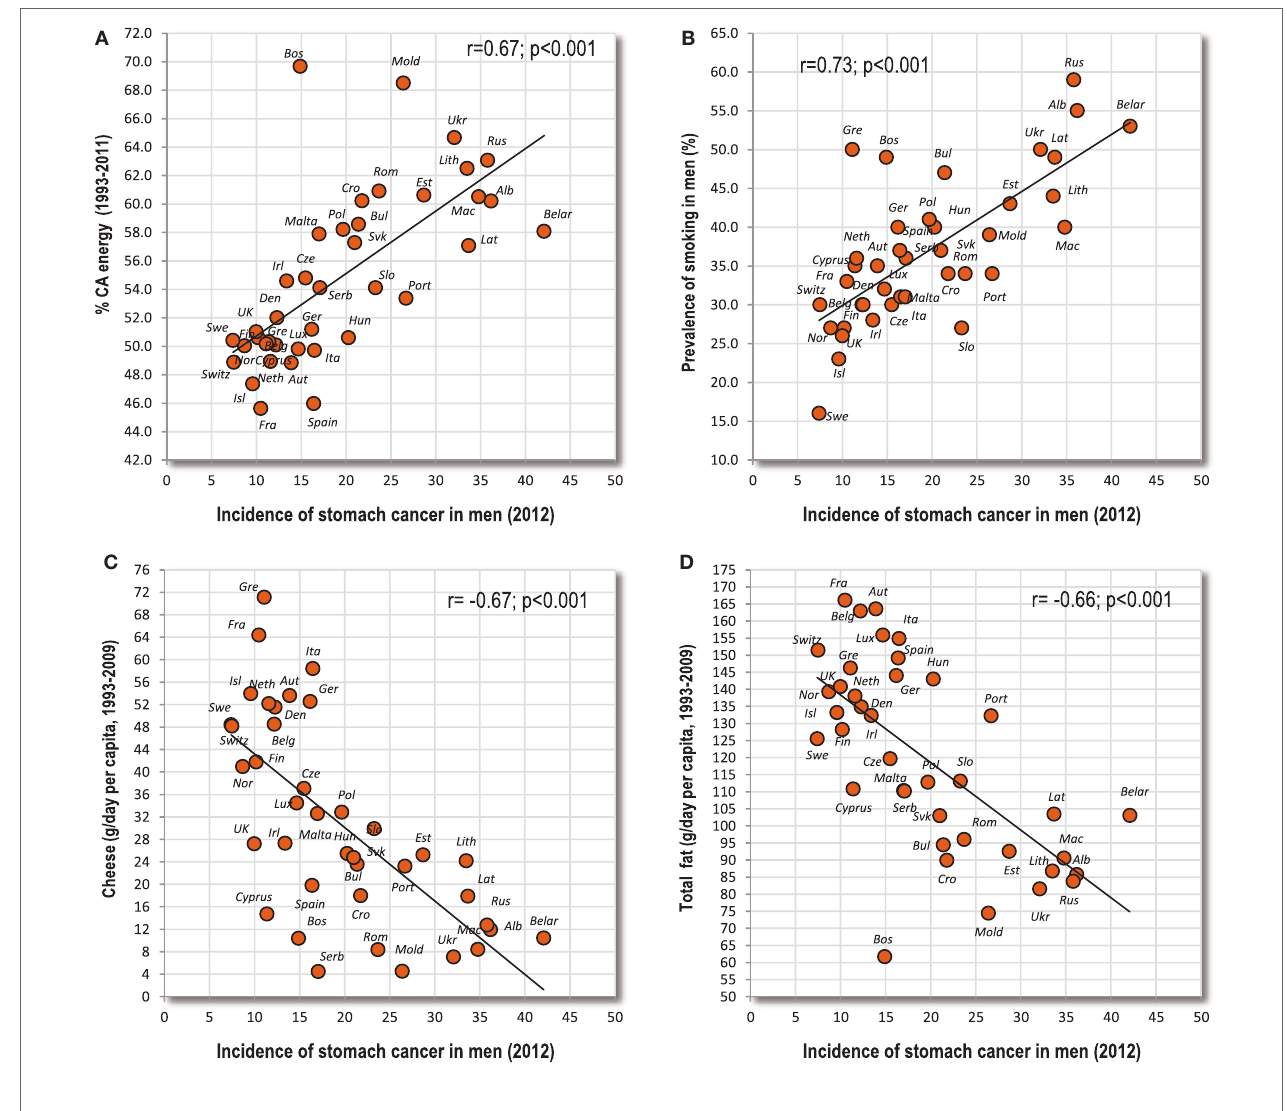
FigUre 4 | (a–D) Relationship between major independent variables and stomach cancer.